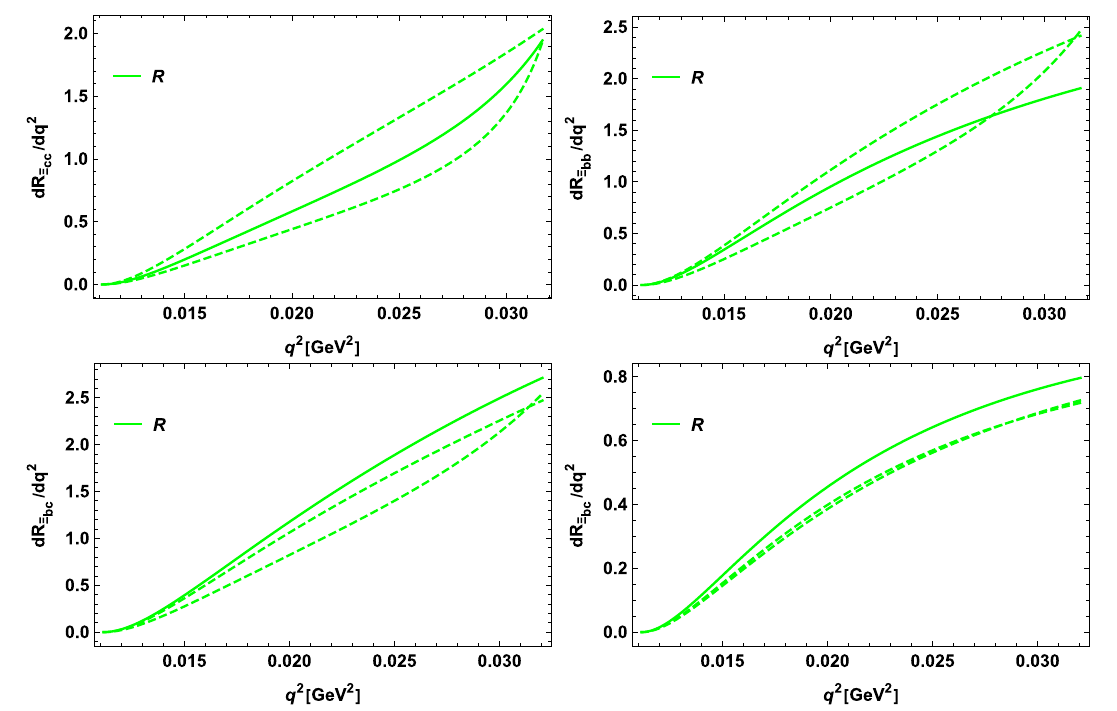
/ dq 2 of spin-1/2 to spin-1/2 doubly heavy baryon decay processes. The R represent the results using F( q 2 ) in Eq. (31) Fig. 4 The d R (cid:5) QQ cesses, the differential decay widths